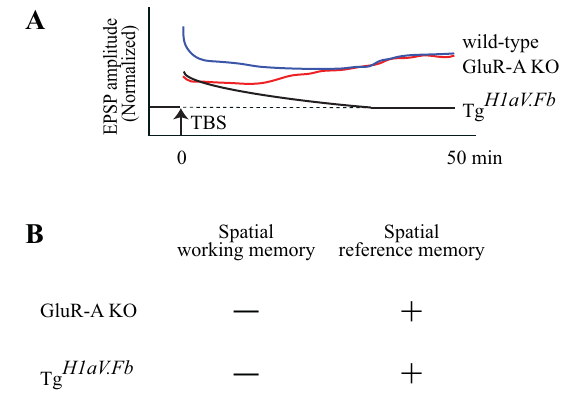
Figure9. Maintenance of LTP after theta-burst stimulation is not required for spatial learning . ( A ) Intracellular recordings from CA1 pyramidal cells show that theta-burst stimulation-induced LTP is differentially expressed in micelackingGluR-A(GluR1)containingAMPAreceptors(GluR-AKO(redtrace); data from Hoffman et al. (2002)) and this report (TgH1aV.Fb, black trace). After TBP stimulation (at time 0), both GluR-A and TgH1aV.Fb mice display impaired early phase of LTP compared to wild-type mice (green trace; representative data from Hoffman et al. (2002)). In GluR-A KO, the postsynaptic responses potentiate. gradually reaching wild-type levels >25 after LTP induction. In TgH1aV.Fb mice, EPSP amplitudes decrease over time, reaching baseline